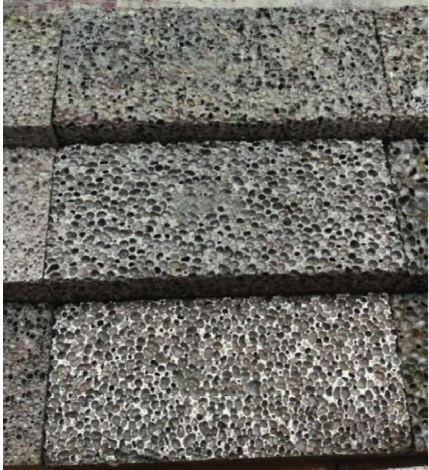
Figure 1: Images of the CCAF